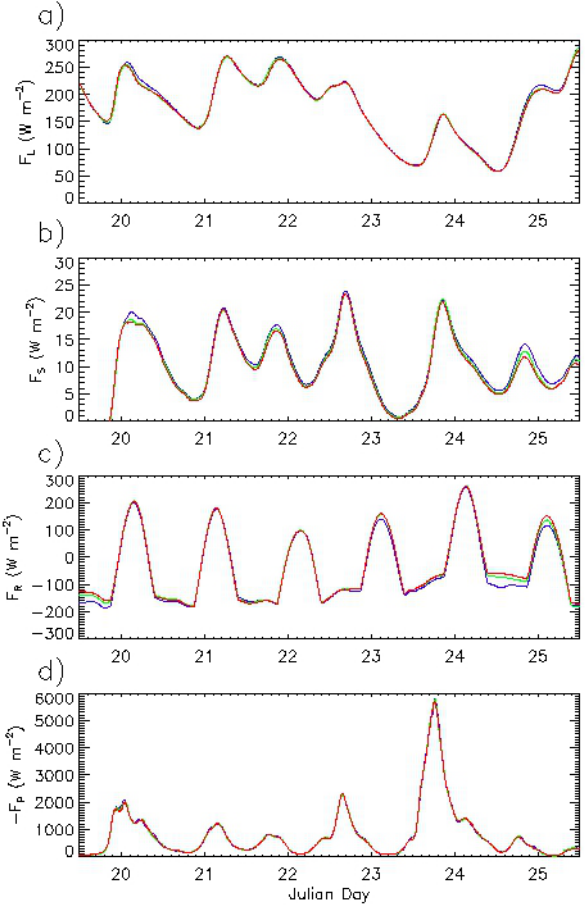
Fig. 11. Timeseries of ensemble- and horizontally-averaged (a) sur- face latent heat flux, F L , (b) surface sensible heat flux, F S , (c) at- mospheric radiative flux convergence, F R , and (d) surface precipi- tation, F P , for PRIS (blue), POLL (green), and SPOLL (red).